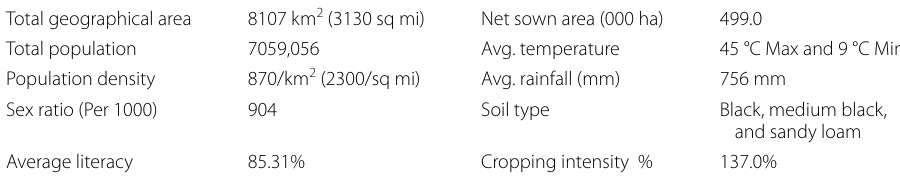
Table 2 Profile of the Ahmedabad district of Gujarat, India. Source : District report 2017 Total geographical